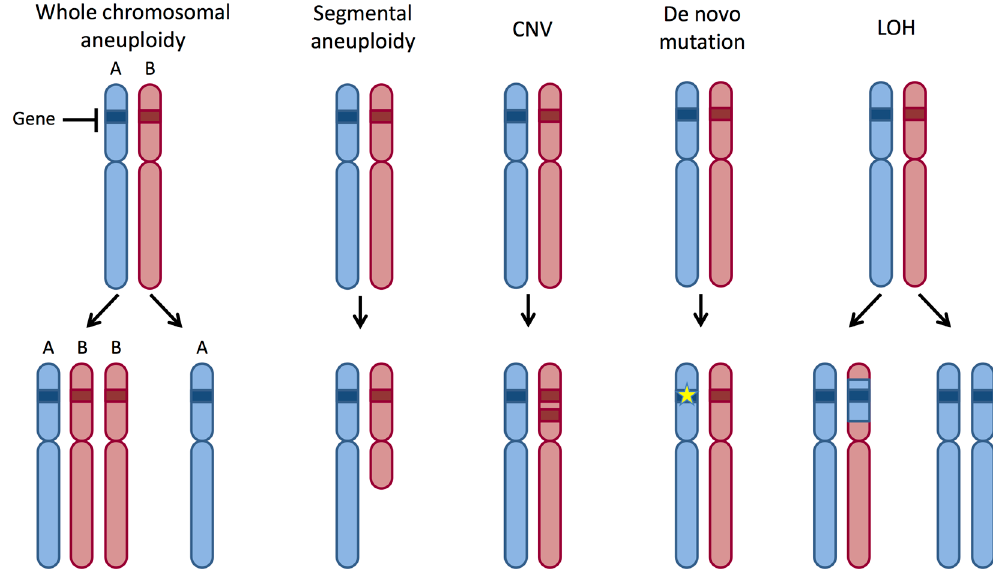
Figure 1. Genetic mechanisms that can impact gene dosage. In a heterozygous diploid strain, each chromosome has two homologs, A and B. Whole chromosomal aneuploidy is a process in which cells gain or lose whole chromosomes. Segmental aneuploidy refers to a gain or loss of a substantial region of a chromosome. Copy number variants (CNVs) arise when the number of copies of a particular gene di ff ers between strains. De novo mutations are mutations that arise within a genome and include single nucleotide polymorphisms (SNPs) and insertions / deletions (indels) that could change gene activity. Loss of heterozygosity (LOH) is a process in which genetic information is lost from one of the two chromosome homologs and can impact either parts of a chromosome or involve whole